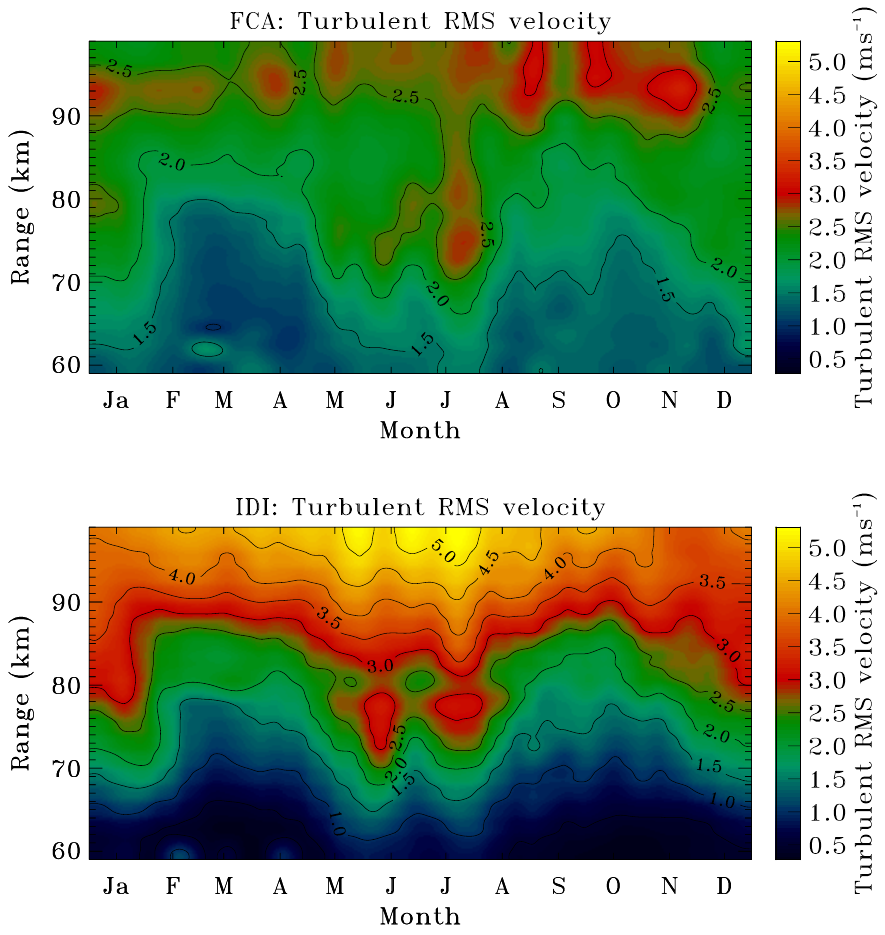
Fig. 10. Annually superposed fortnightly averaged FCA (top) and IDI (bottom) turbulent